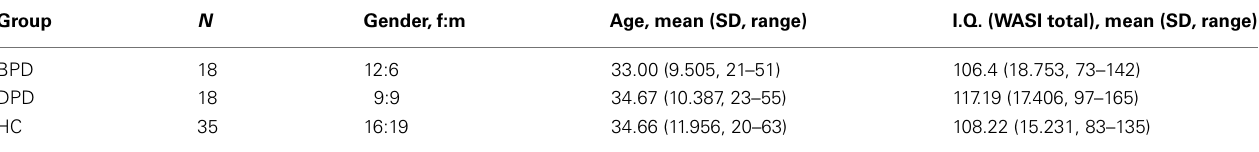
Table 1 | Demographics.